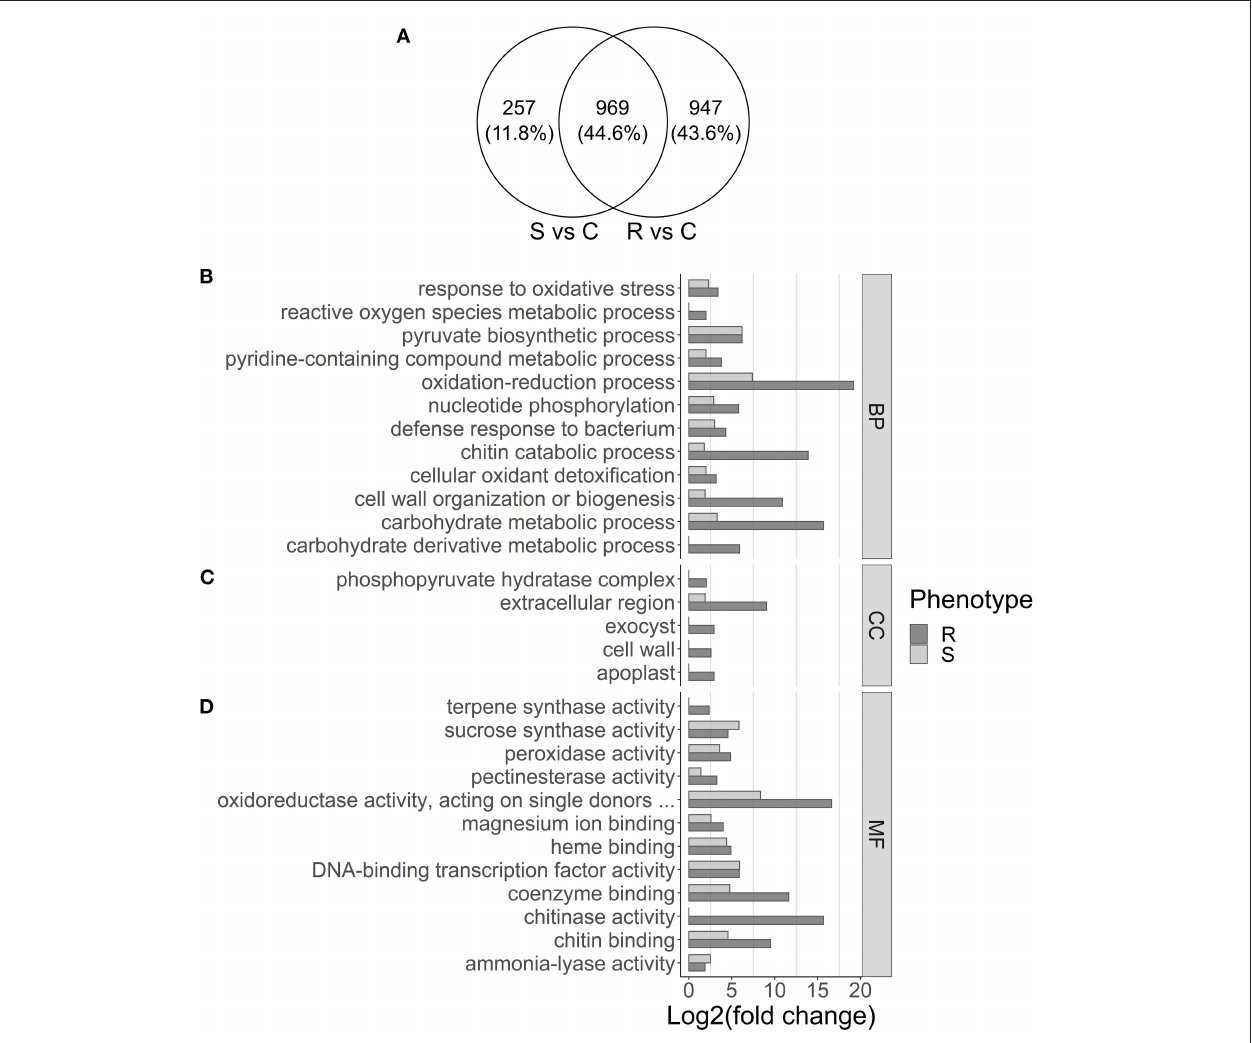
FIGURE 2 | Venn diagram showing overlap of differentially expressed genes in susceptible (S) and resistant (R) samples (A) and gene set enrichment analysis (B–D). (A) Differential expression was calculated by comparing susceptible (S) or resistant (R) samples with controls (C). (B–D) GO terms overrepresented in the upregulated genes in resistant (dark gray) and susceptible (light gray) samples are displayed, separated by (B) biological process (BP), (C) cellular component (CC), and (D) molecular function (MF). The x-axis represents the significance of GO enrichment (–log10 of corrected p